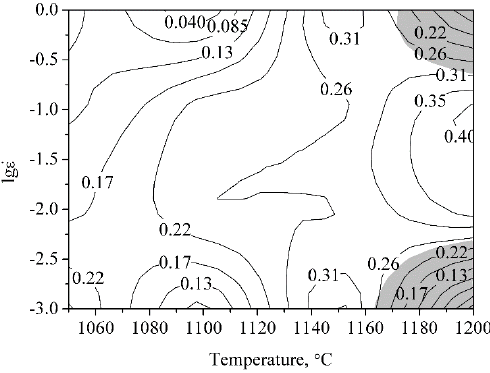
Figure 5. Processing map of the ODS sample at a true strain of 0.5.